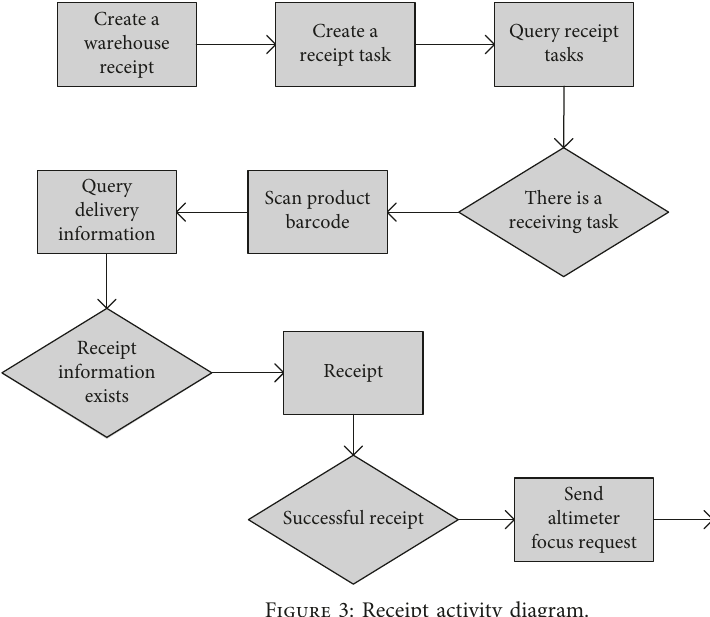
Figure 3: Receipt activity diagram.